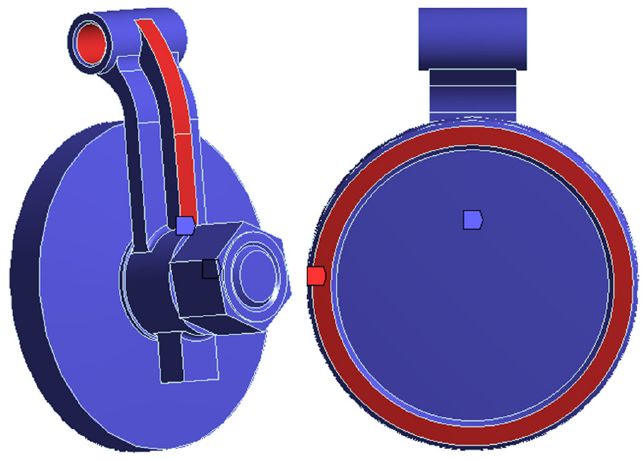
Figure 13. Topology optimization domain.